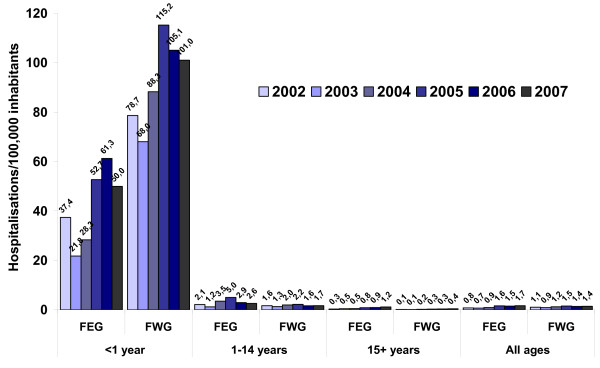
Hospitalizations for pertussis per 100.000 inhabitants according to age and residence in former East (FEG) and West (FWG) Germany, 2002–2007 (Source of data: Statistics of hospital diagnoses, Federal Statistical Office, available at http://www.gbe-bund.de/gbe10/abrechnung.prc_abr_test_logon?p_uid=gast&p_aid=&p_sprache=D&p_knoten=VR&p_suchstring=pertussis.